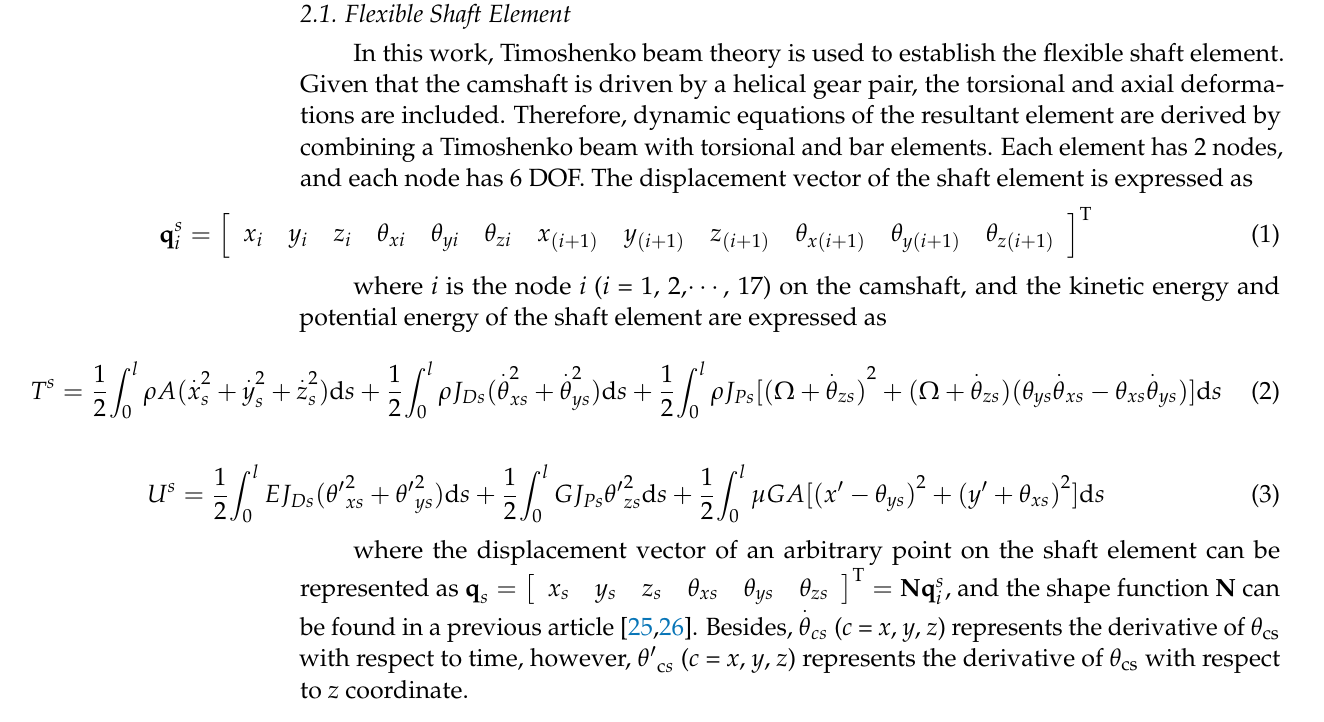
Figure 1. Flexible dynamics model of the valve train system. Table 1. Structural parameters of the shaft elements.